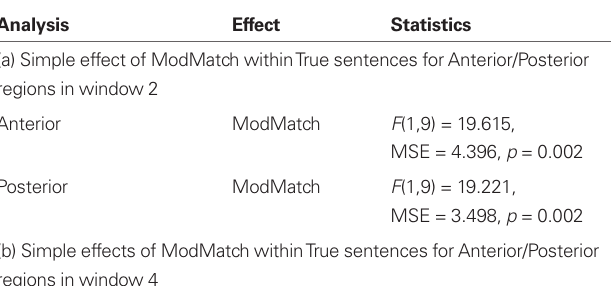
Table a2 | Full results of the simple effects follow-up